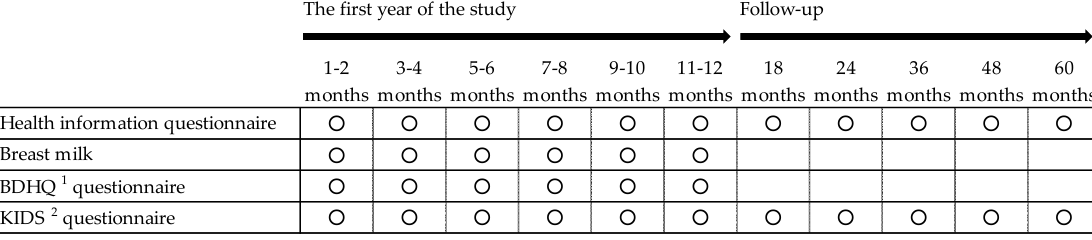
Figure 2. The study timeframe. 1 BDHQ, brief-type self-administrated diet history questionnaire. 2 KIDS, kinder infant development scale.